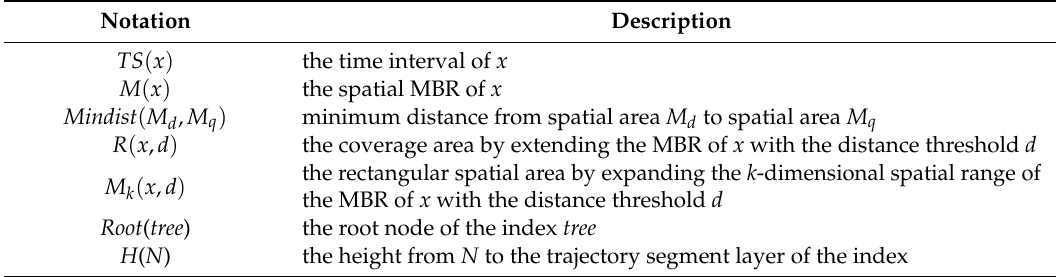
Table 1. Frequently used notations.